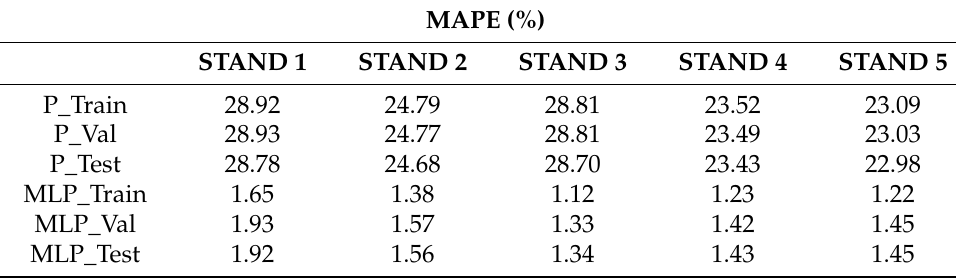
Table 14. Comparison of the motor load prediction using MAPE.